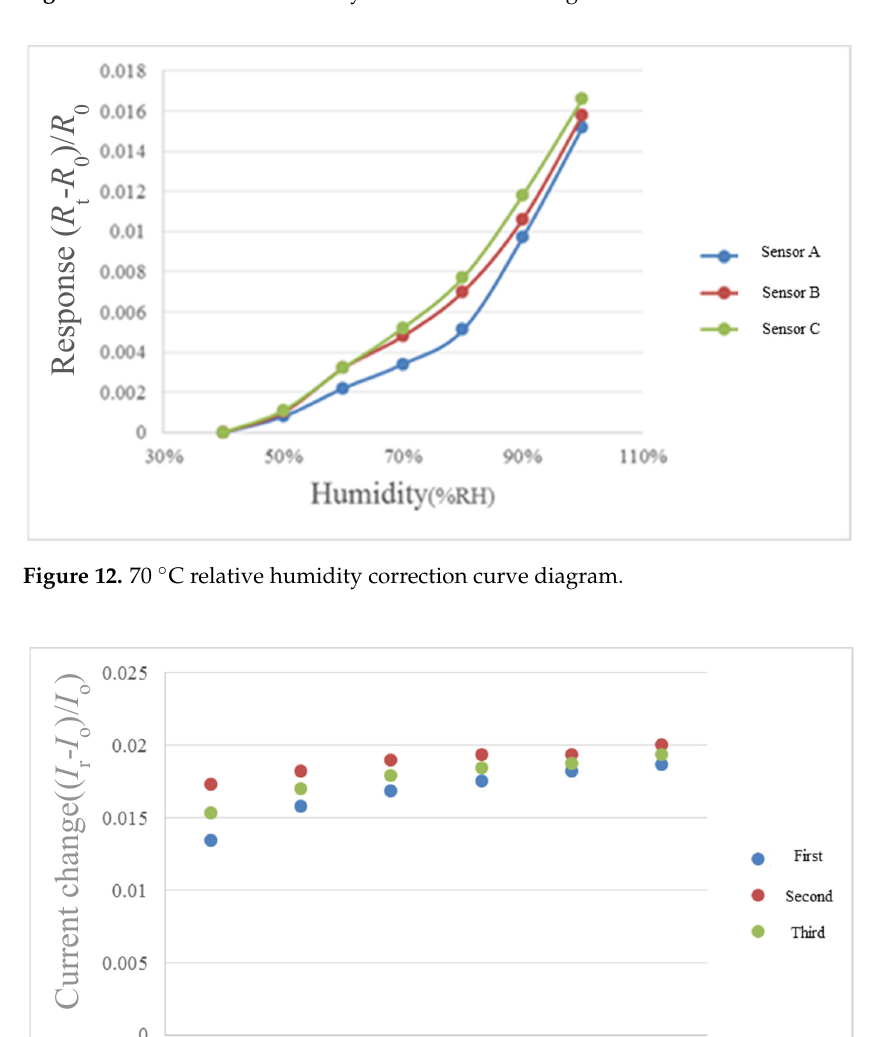
Figure 11. 50 °C relative humidity correction curve diagram.